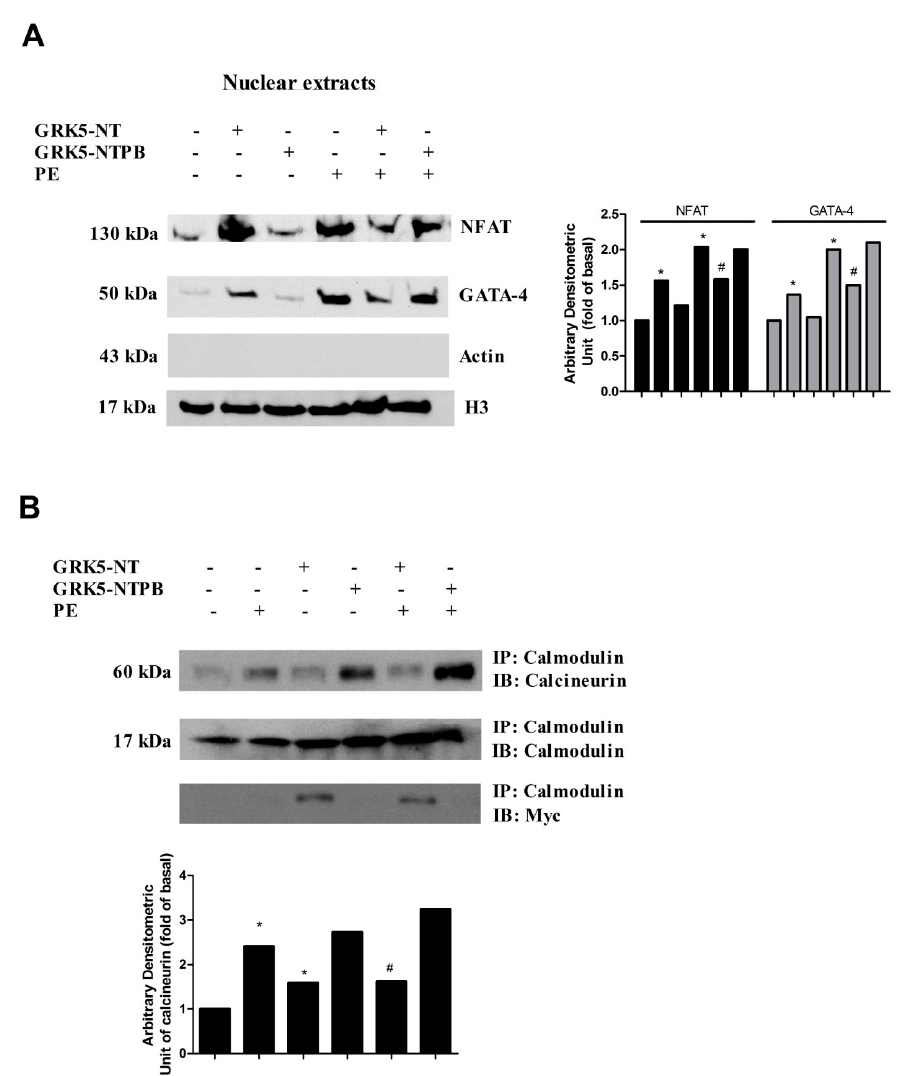
Figure 2. The amino-terminal domain of the G Protein Coupled Receptor Kinase 5 (GRK5-NT) inhibits NFAT activation by sequestrating calmodulin. ( A ) Cardiomyoblasts were transfected with a plasmid encoding GRK5-NT or GRK5-NTPB and NFAT and GATA-4 nuclear translocation was evaluated by western blot in presence and absence of phenylephrine (PE). GRK5-NTPB had no significant effect on nuclear translocation and activation of NFAT and GATA4; instead GRK5-NT inhibited such phenomenon. Actin was used as control of nuclear extracts purity and histone 3 (H3) was used as loading control. Densitometric analysis is shown in bar graph as mean ± SD, * p < 0.05 vs. Control and # p < 0.05 vs. PE; ( B ) cardiomyoblasts were transfected with a plasmid encoding GRK5-NT or GRK5-NTPB and calmodulin was precipitated in whole lysates from these cells. Calcineurin was evaluated by western blot. GRK5-NT reduced calmodulin/calcineurin interaction. GRK5-NTPB had no effect on such interaction. All images are representative of three independent experiments. Densitometric analysis is shown in bar graph as mean ± SD, * p < 0.05 vs. Control and # p < 0.05 vs. PE.